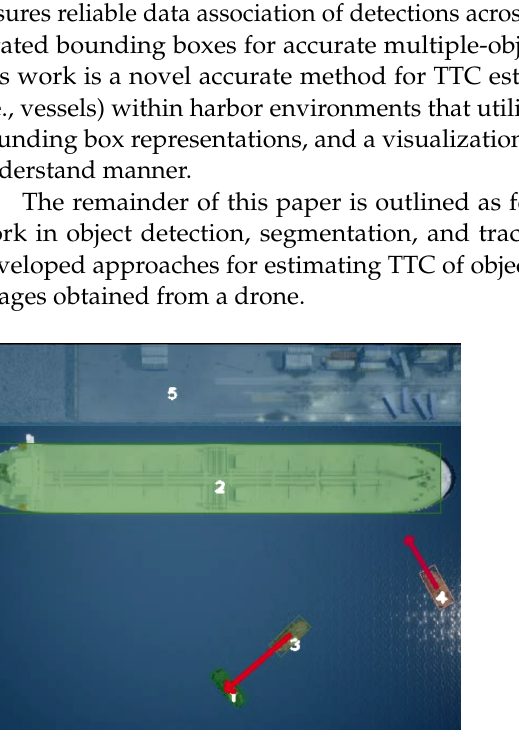
Figure 1. Image of four vessels in collision route gathered by an autonomous UAV, and TTC estimated using our real-time